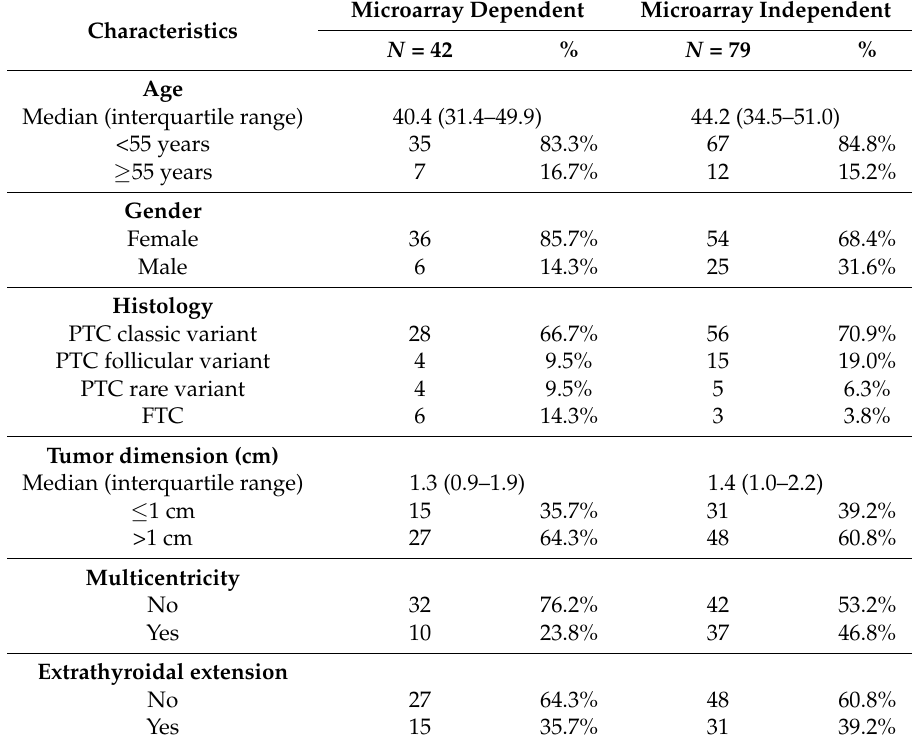
Table 2. Clinical and pathological features of well-differentiated thyroid carcinomas (WDTC) patients enrolled in the